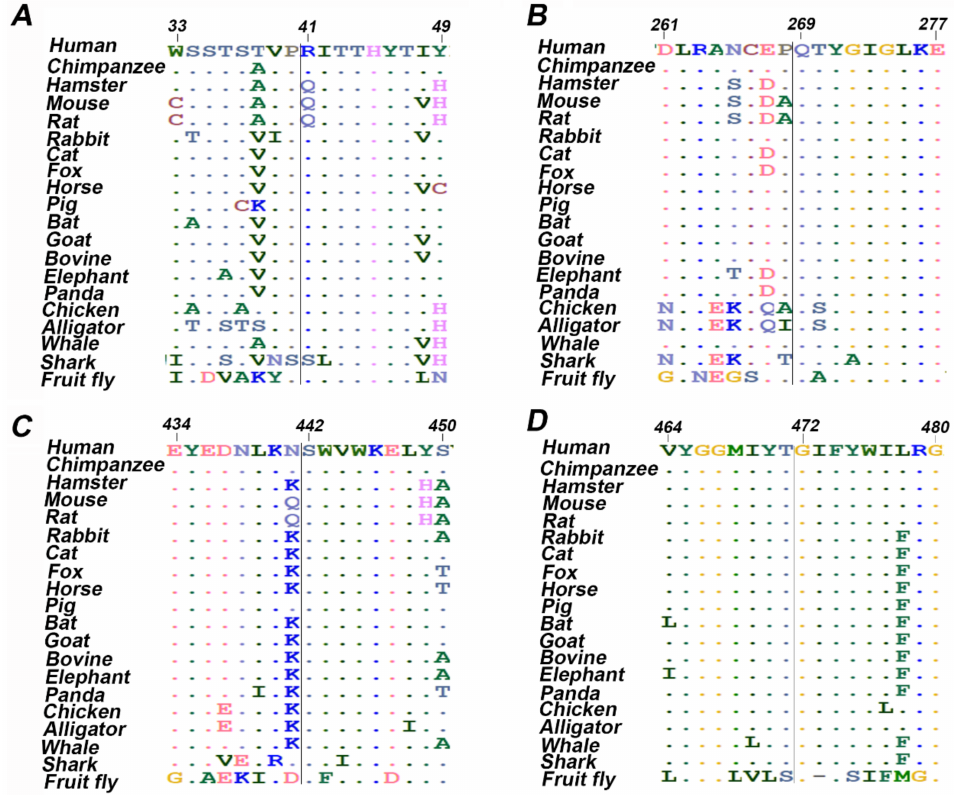
Figure 1. Multiple sequence alignment of twenty amino acids centered on the missense mutation obtained from different organisms. ( A ) ETF-QO, R41L; ( B ) ETF-QO, Q269H; ( C ) ETF-QO, S442L; ( D ) ETF-QO, G472R.